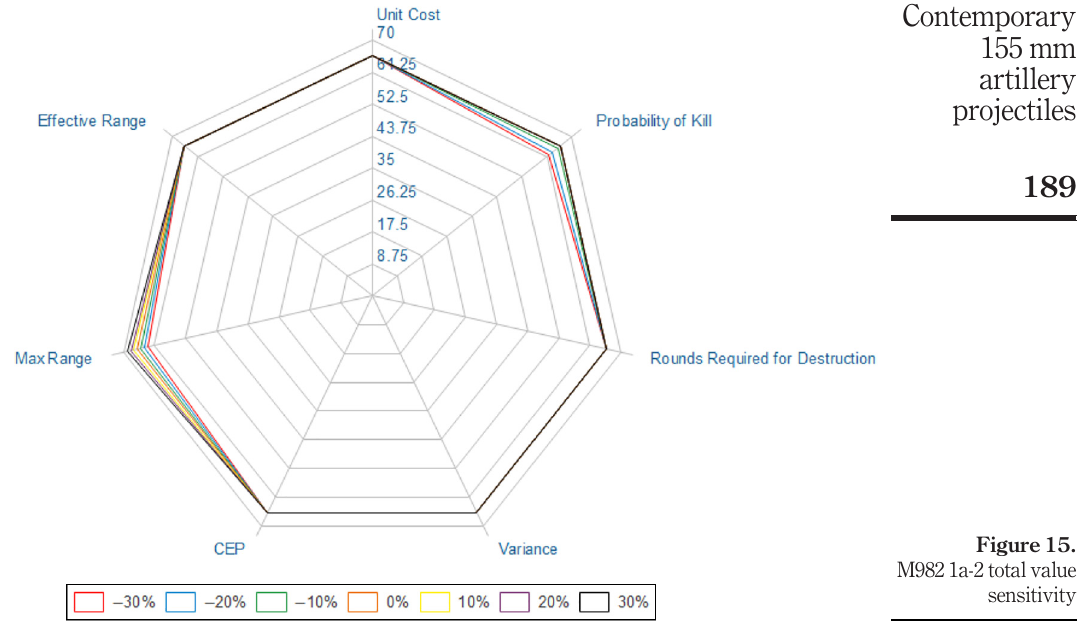
Figure 15. M982 1a-2 total value